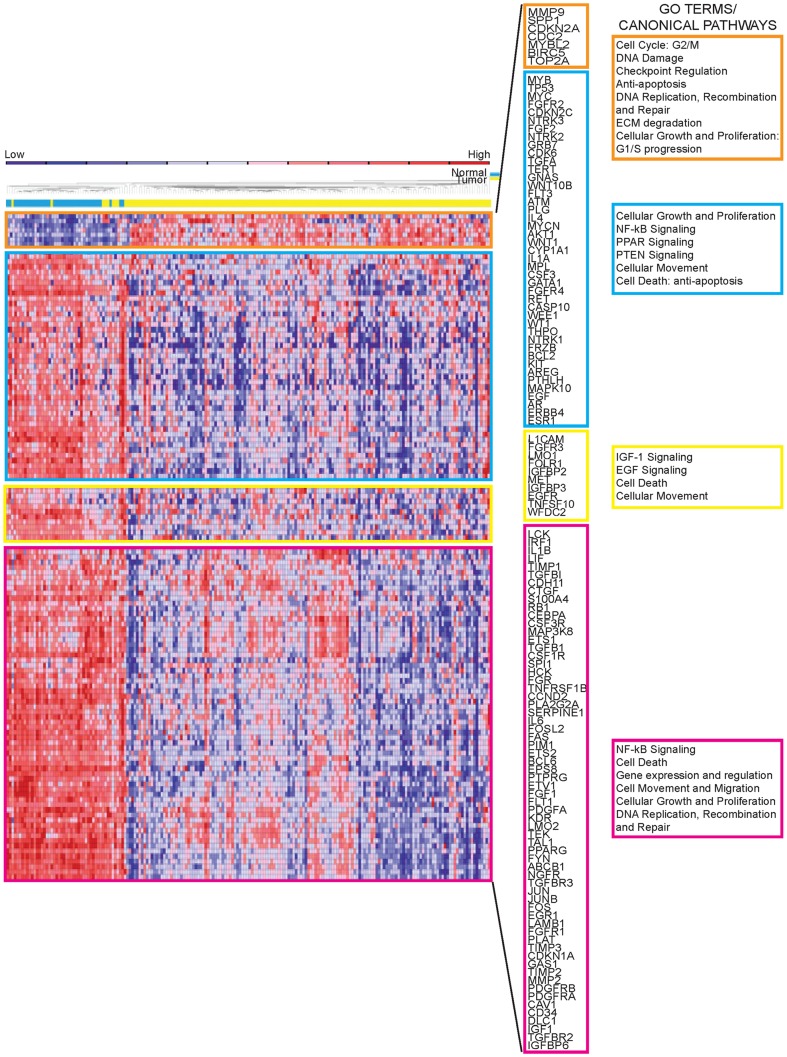
Comparison of mRNA expression profiles of normal vs tumor RNAs.The heat maps represent hierarchical clustering of differentially expressed genes in normal and tumor-derived RNAs. mRNA profiles are clustered in 4 different subgroups (orange, blue, yellow, pink) defined by the mRNA expression patterns. Overlapping Gene Ontology terms for top canonical pathways represented by the differentially expressed genes in each subgroup, as determined by IPA-ingenuity software, are shown on the right for each of the normal/tumor comparison-defined subgroups.